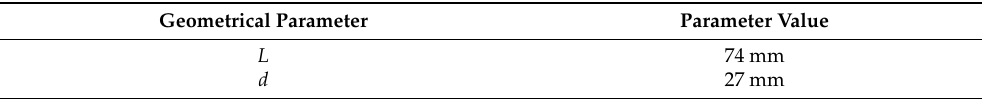
Table 1. Geometric parameters of cycloidal